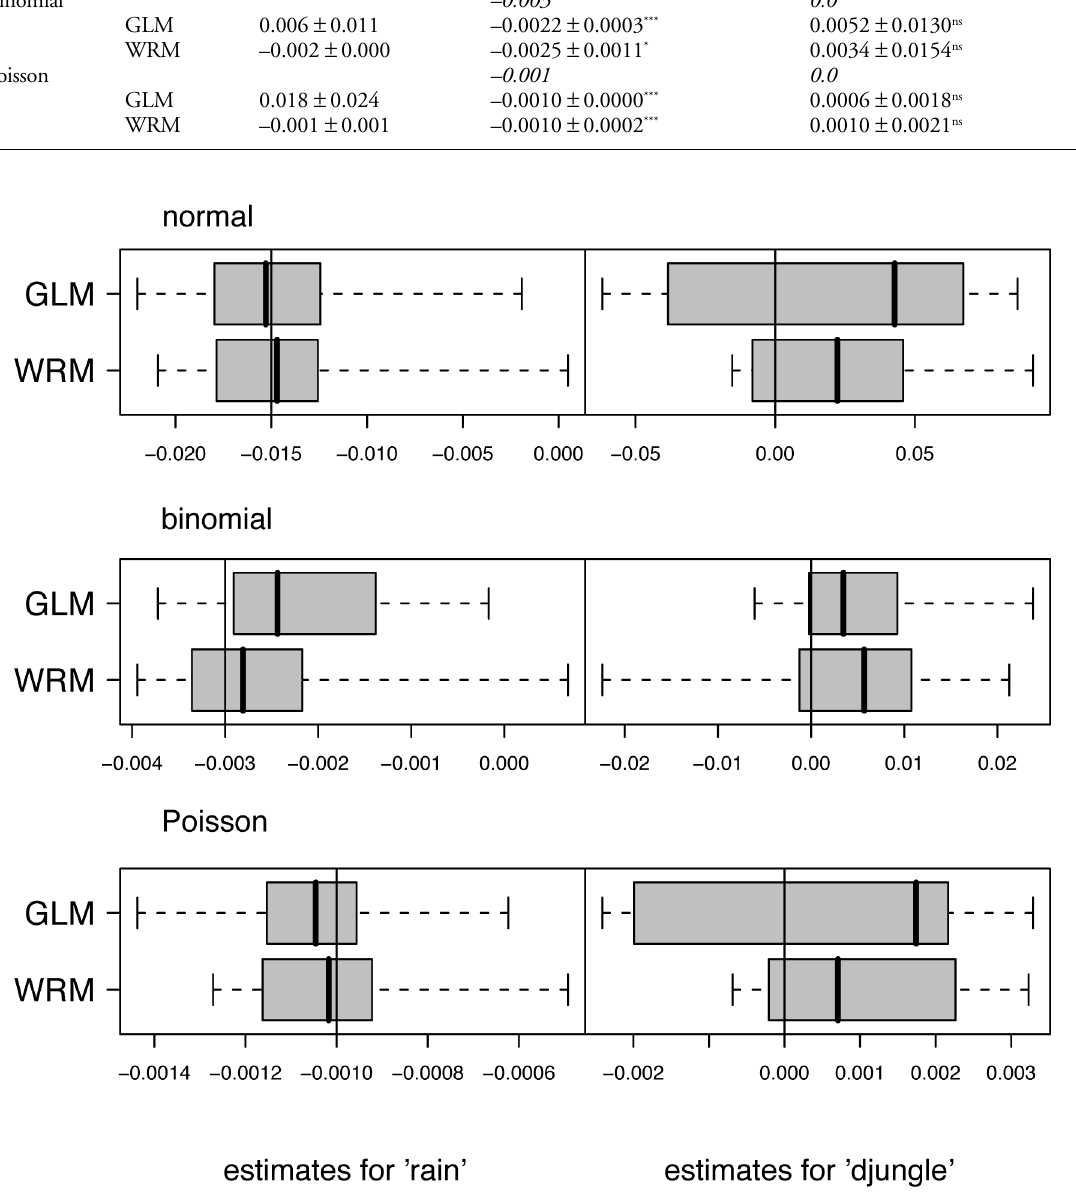
Fig. 1. Comparison of non-spatial (GLM) and spatial (WRM) modelling approaches for data with normally, binomially and Poisson- distributed responses. Box and whiskers refer to 25/75%, 0/100%. Vertical lines indicate true values of